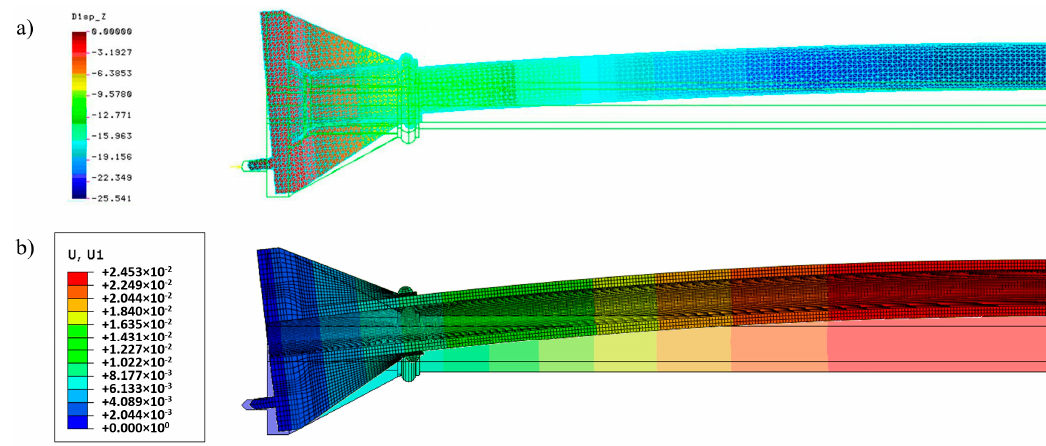
Figure 6. Lateral displacement distribution of original column in the linear elastic analysis for N = 100 kN in different systems: ( a ) COSMOS/M; ( b ) Simulia Abaqus.